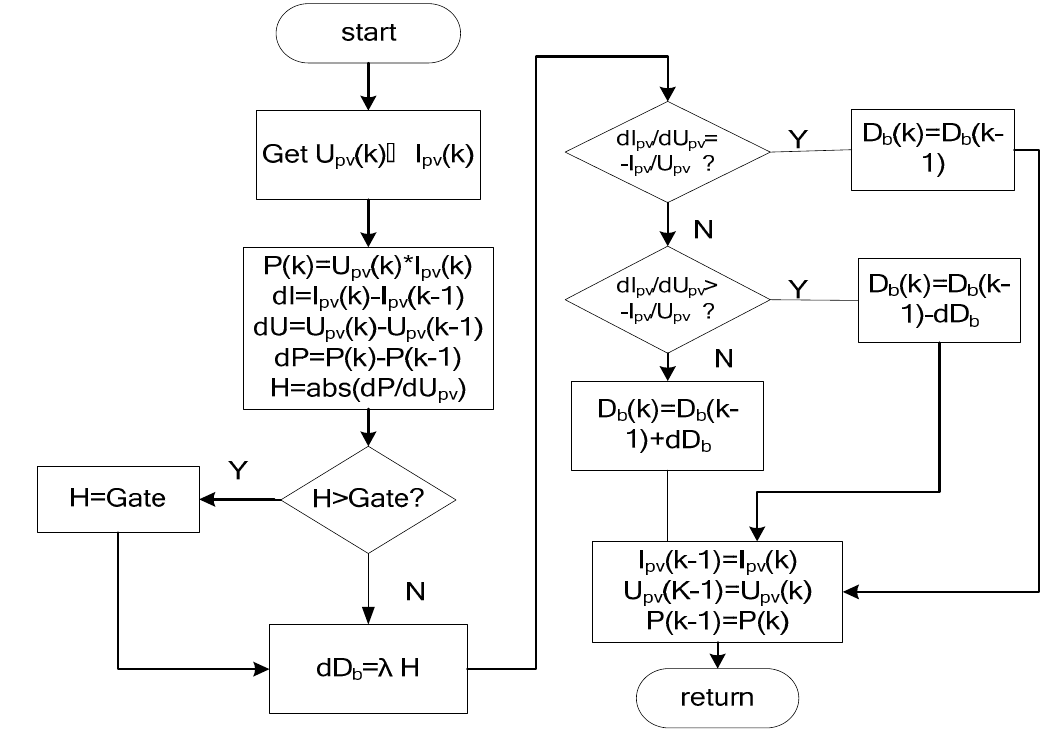
Figure 5. INC with adaptive size.